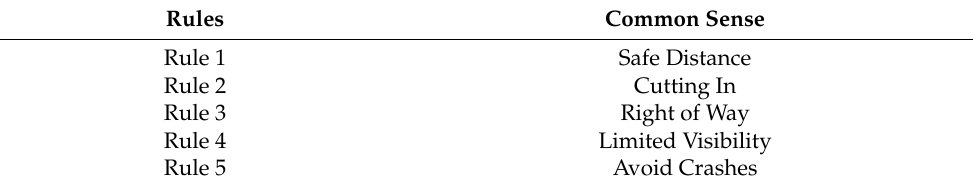
Table 1. The 5 rules of the RSS